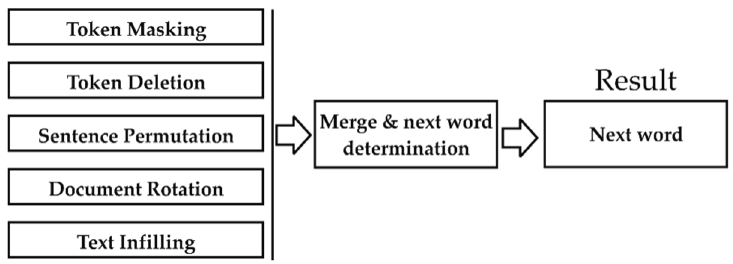
Figure 3. BART Transformations for next-word generator. Table 3. Examples of Counterfeit Generated Document. Table 3. Examples of Counterfeit Generated